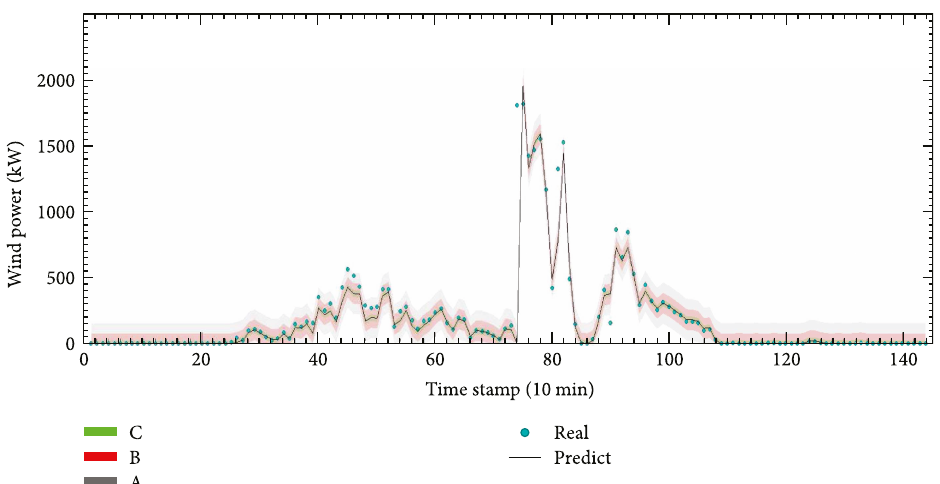
Figure 5: Fuzzy interval prediction for one day ahead (case 2) wind power with coverage grades.